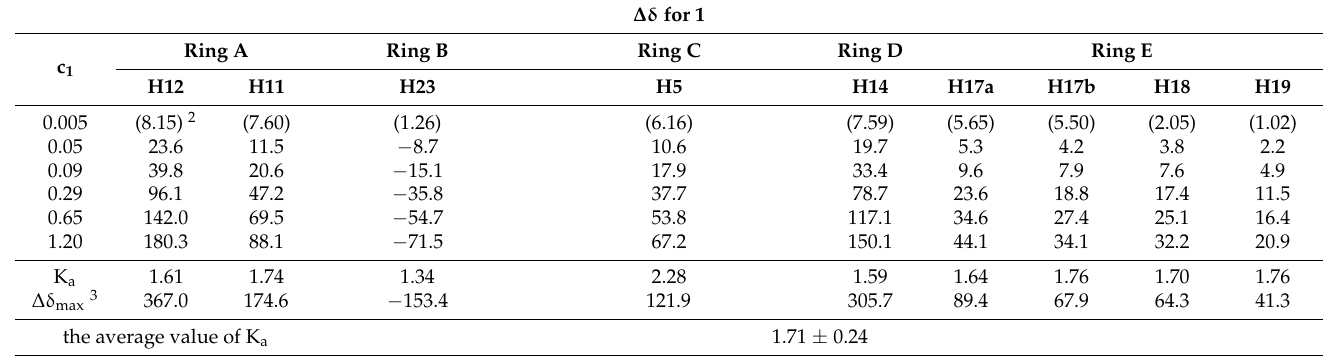
Table 1. The chemical shift changes, ∆ δ 1 [Hz], of the proton signals of 1 and 2 in D 2 O buffer (25 mM NaCl/25 mM K 3 PO 4 , TSPA- d 4 ) for different concentrations c [mM], pH 6.4, temp. 10 ◦ C. The isodesmic association constants K a [mM − 1 ]. ∆ δ for